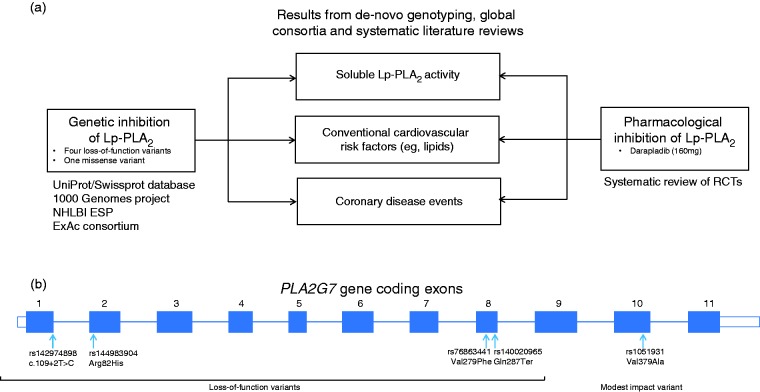
Summary of study design. (a) Flow chart of study design. (b) Exonic structure of the PLA2G7 gene and location of variants used in this study. ExAc: Exome Aggregation consortium; NHLBI ESP: National Heart Lung and Blood Institute Exome Sequencing Project; Lp-PLA2: lipoprotein-associated phospholipase A2; RCT: randomized controlled trial; UniProt/Swissprot: manually annotated and reviewed section of the Universal Protein resource database.